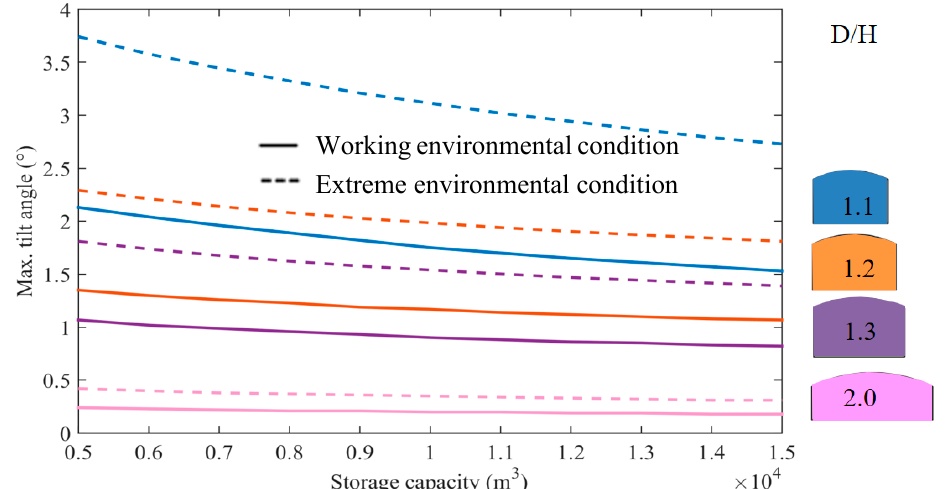
Figure 18. Maximum tilting angle of double-hull storage tanks (L/D = 1.2).